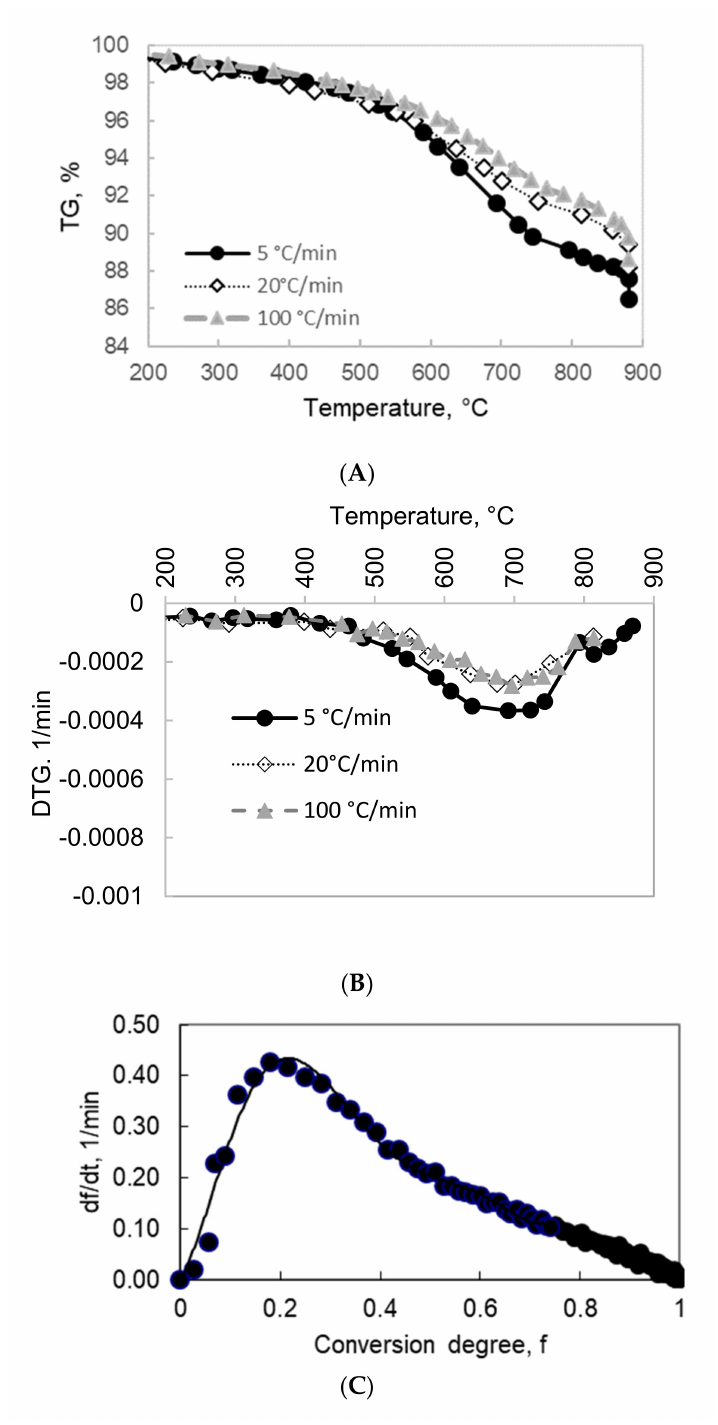
Figure 13. ( A ):TG and ( B ): DTG curves of Pet-coke pyrolysis in nitrogen at different heating rates. ( C ): Instantaneous rate of carbon conversion, df/dt, versus f of pet-coke char at 530 ◦ C in air